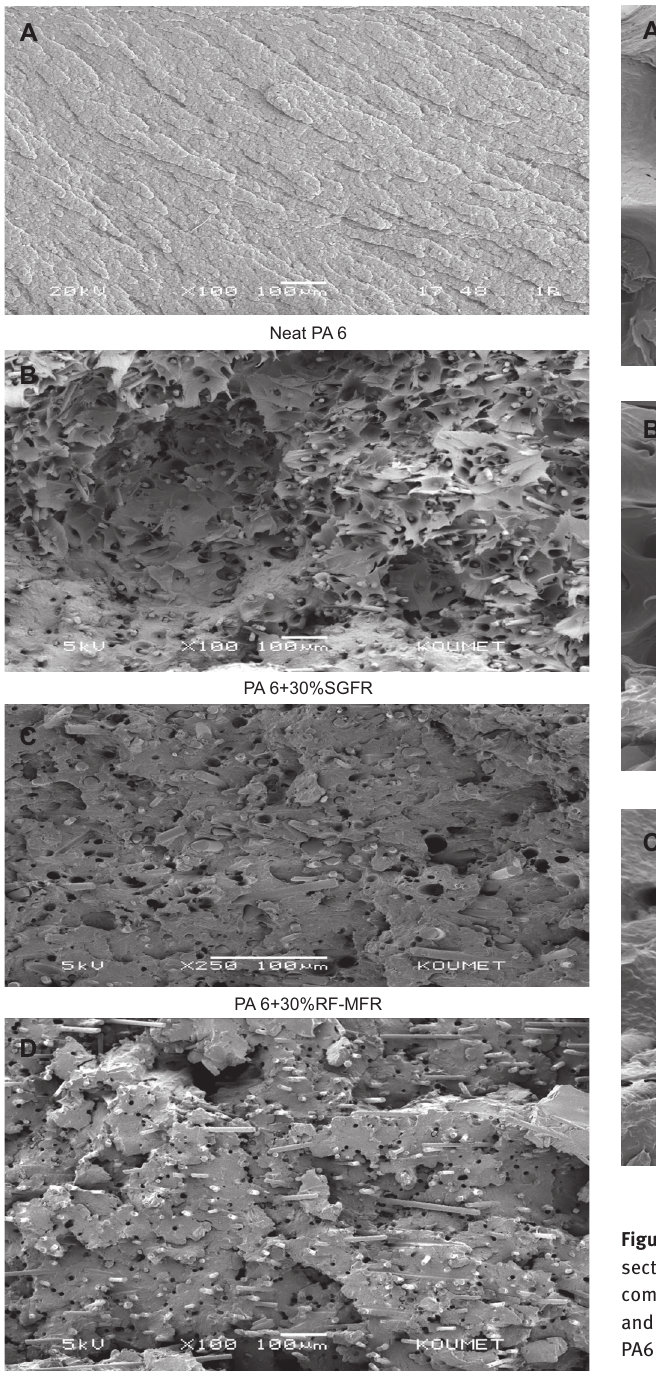
Figure 8 Scanning electron micrograph of tensile fracture cross section for PA6 with (A) neat PA6, (B) 30 wt% short glass fiber-rein- forced PA6 composite, (C) 30 wt% RF-mineral fiber-reinforced PA6 composite, and (D) 20 wt% short glass fiber+10 wt% RF-mineral- fiber reinforced PA6 hybrid composite.